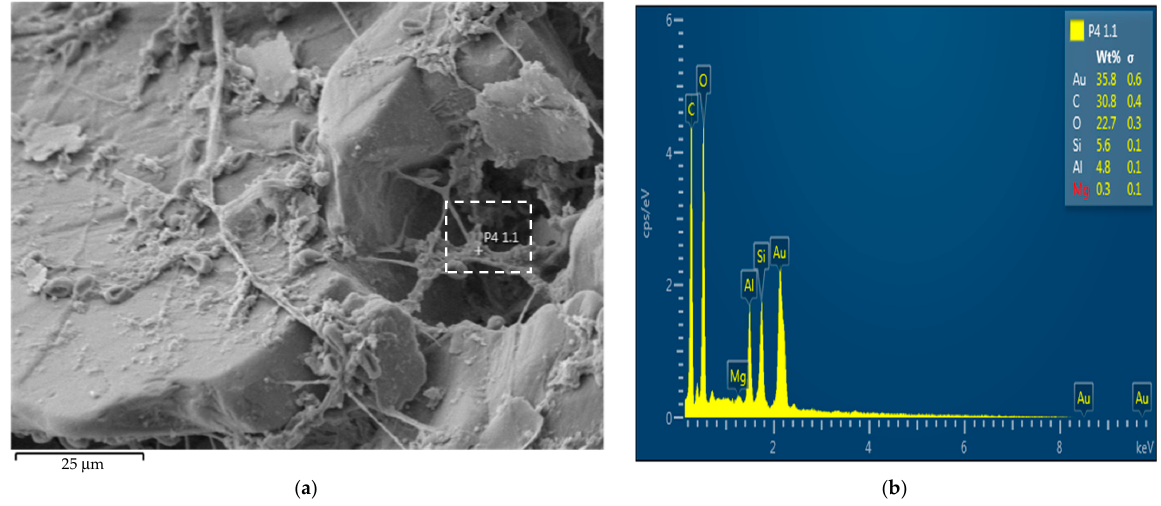
Figure 9. ( a ) Area targeted (P4 1.1) for the chemical analysis. ( b ) Chemical analysis of the LabXLG-soil specimen.